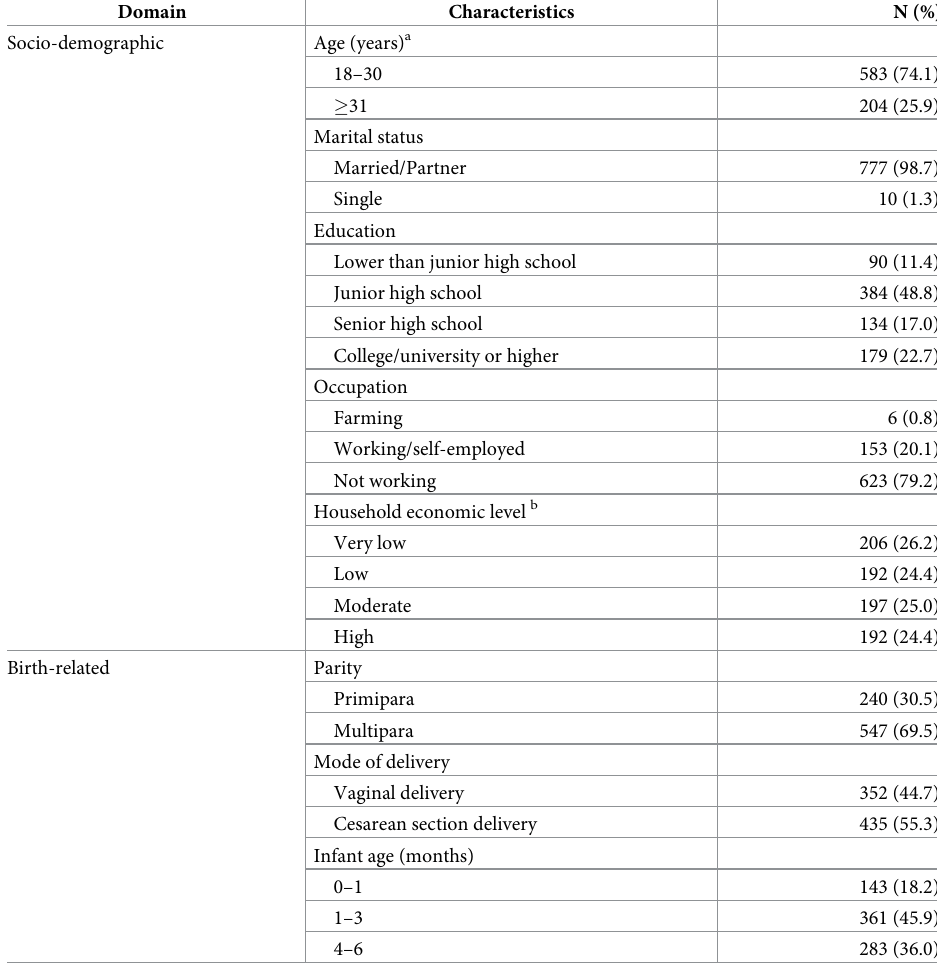
Table 1. Descriptive characteristics of postpartum women in rural China (N =